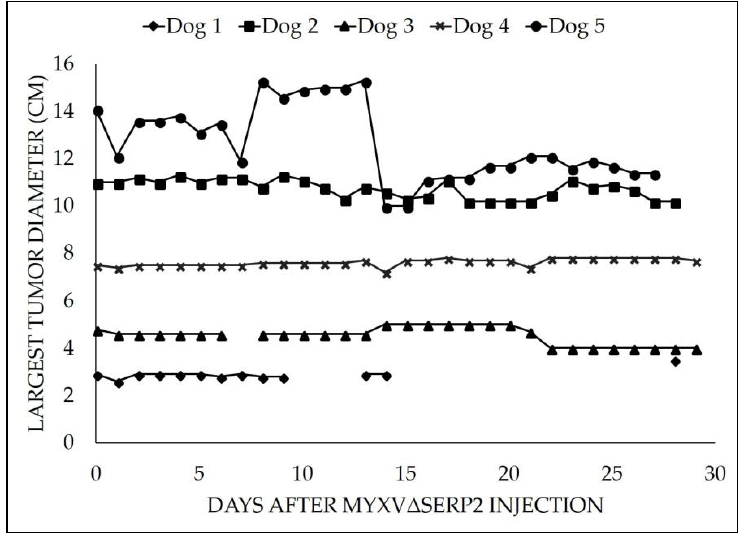
Figure 2. Largest tumor diameter by caliper measurement after an intratumoral injection of 10 6 pfu MYXVΔserp2 in dogs with spontaneously arising soft tissue sarcomas.